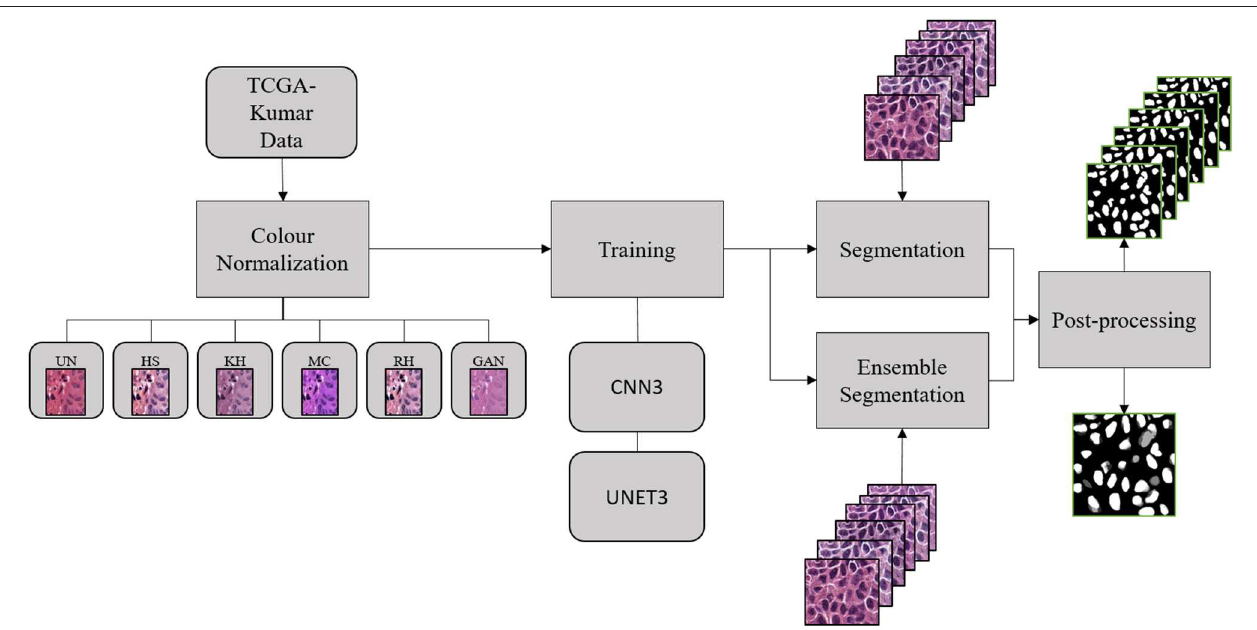
FIGURE 1 | Experimental